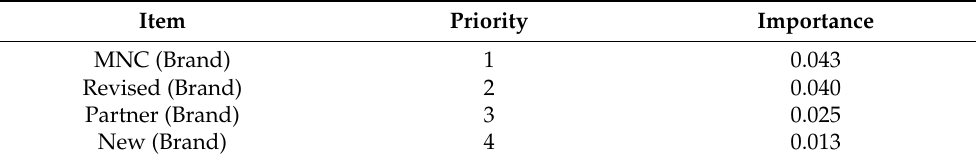
Table 11. Results of brand.